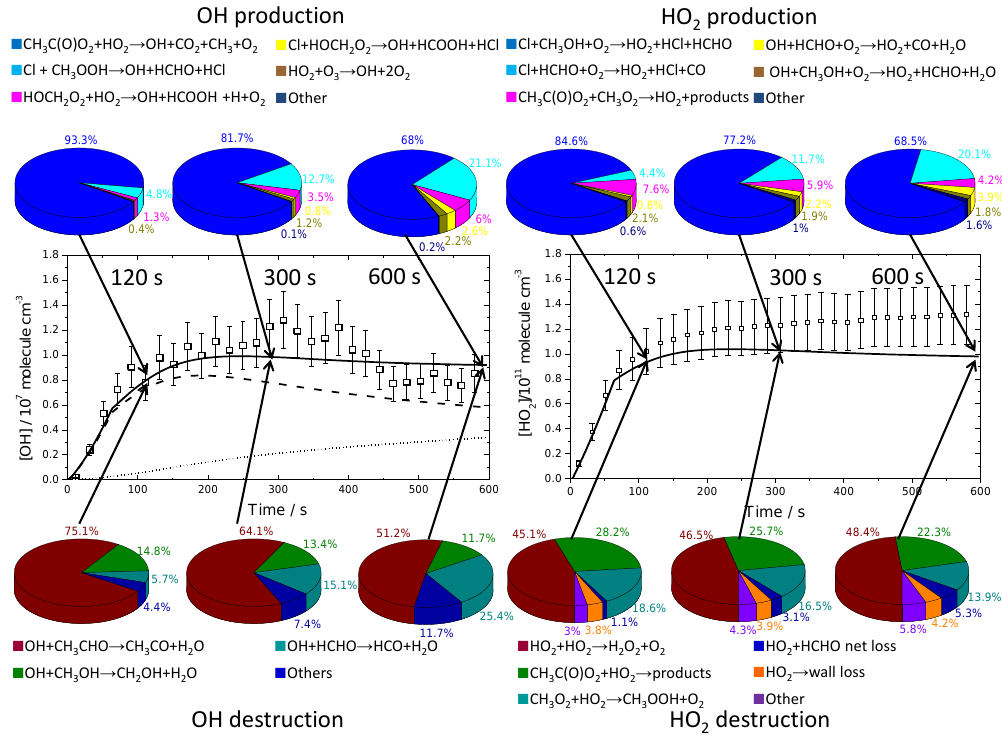
Figure 3. The OH and HO 2 time profiles during experiment P1, [CH 3 OH] 0 :[CH 3 CHO] 0 ≈ 4, 1000mbar in air and 293K, where pho- tolysis was initiated at t = 0s. Chemical model predictions also shown (solid lines) calculated using optimised branching ratios (P1) α (R5c) = 0.45 ± 0.08 calculated using the fitted k (R5) = 2.4 × 10 − 11 cm 3 molecule − 1 s − 1 . Contribution to total [OH] from Reaction (R5c) and all other secondary sources are shown as dashed and dotted traces respectively. Error bars represent uncertainty to ± 1 σ in the FAGE calibration procedure. Above and below each profile are shown rate of production and rate of destruction analyses at 120, 300, and 600s. OH production is dominated by the title reaction and OH loss processes are predominantly controlled by well-characterised reactions. HO 2 production and loss is controlled by more reactions, but these too are well-characterised.